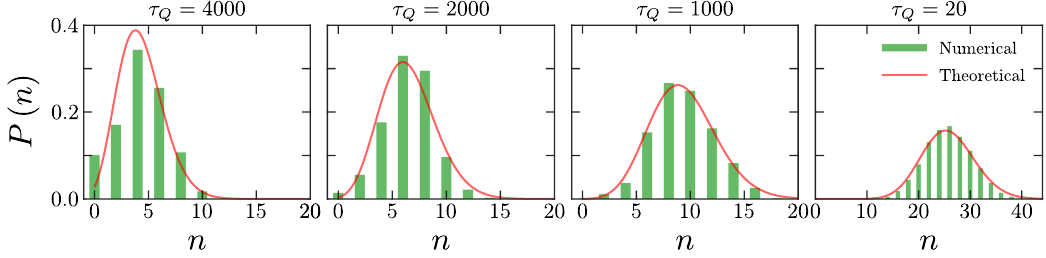
Figure 2 . Histogram for the vortex-number probability distribution for various quench times. The distribution is asymmetric at the onset of adiabatic dynamics and becomes symmetric for faster thermal quenches that increase the average vortex number. Numerical simulations are well described by the EP distribution in eq. (4.2) with the same average vortex number h n i . The size of the system is 50 × 50 and the number of trajectories for each τ Q is